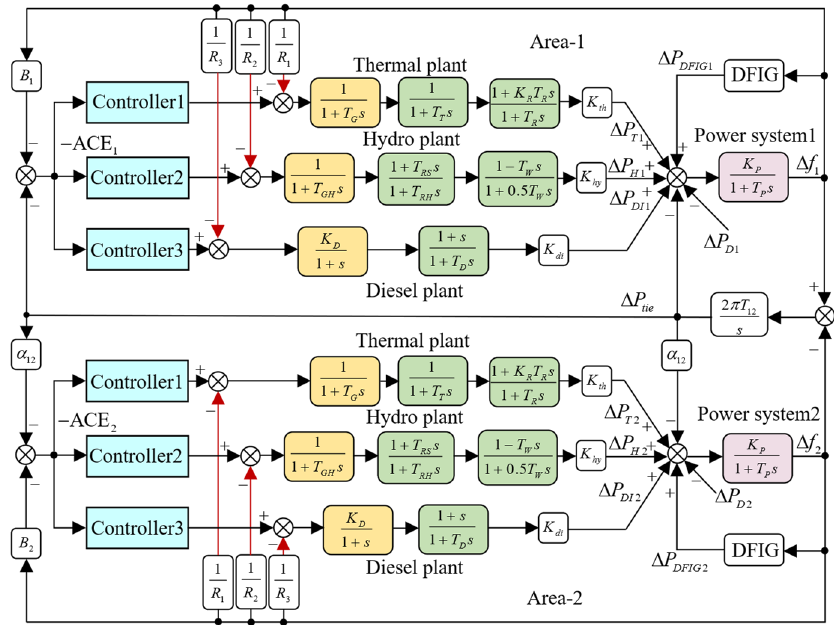
Figure 1. Two-area interconnected power system.